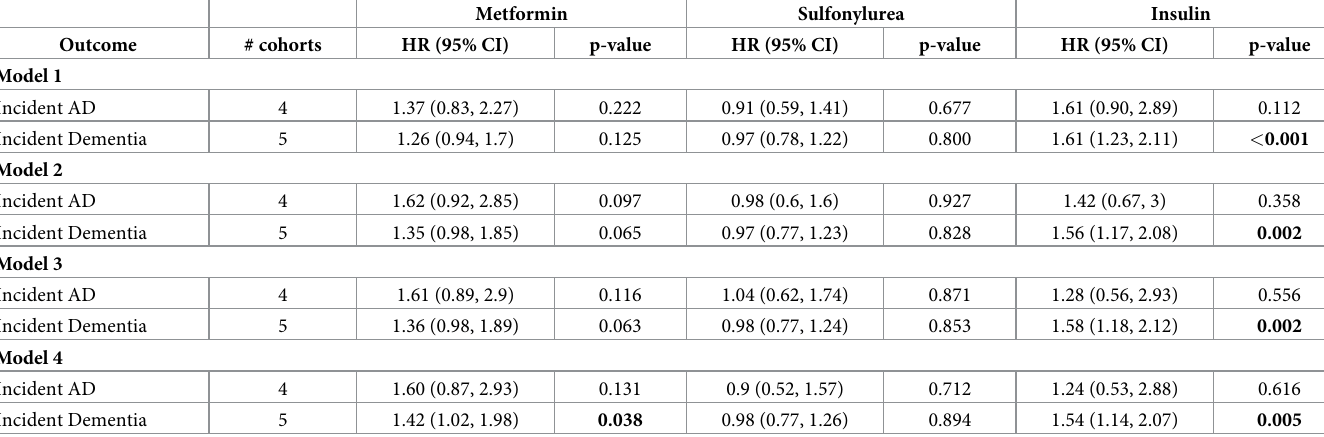
Table 2. Associations of diabetes drug classes (single or in combination) with risk of dementia/AD among individuals with diabetes- fixed effects meta-analysis. Metformin Insulin